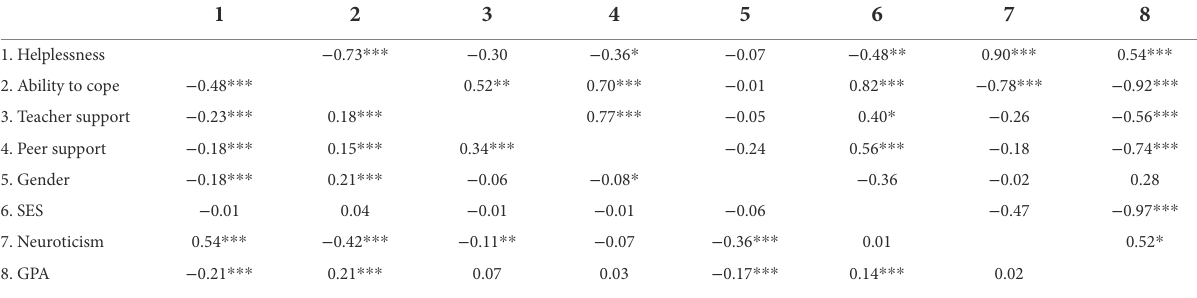
TABLE 1 Zero-order correlation coefficients among all study variables at student and classroom